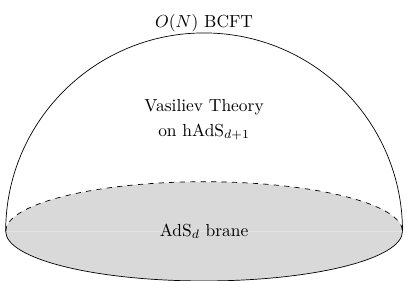
Figure 2 . AdS/ BCFT setup for O( N )